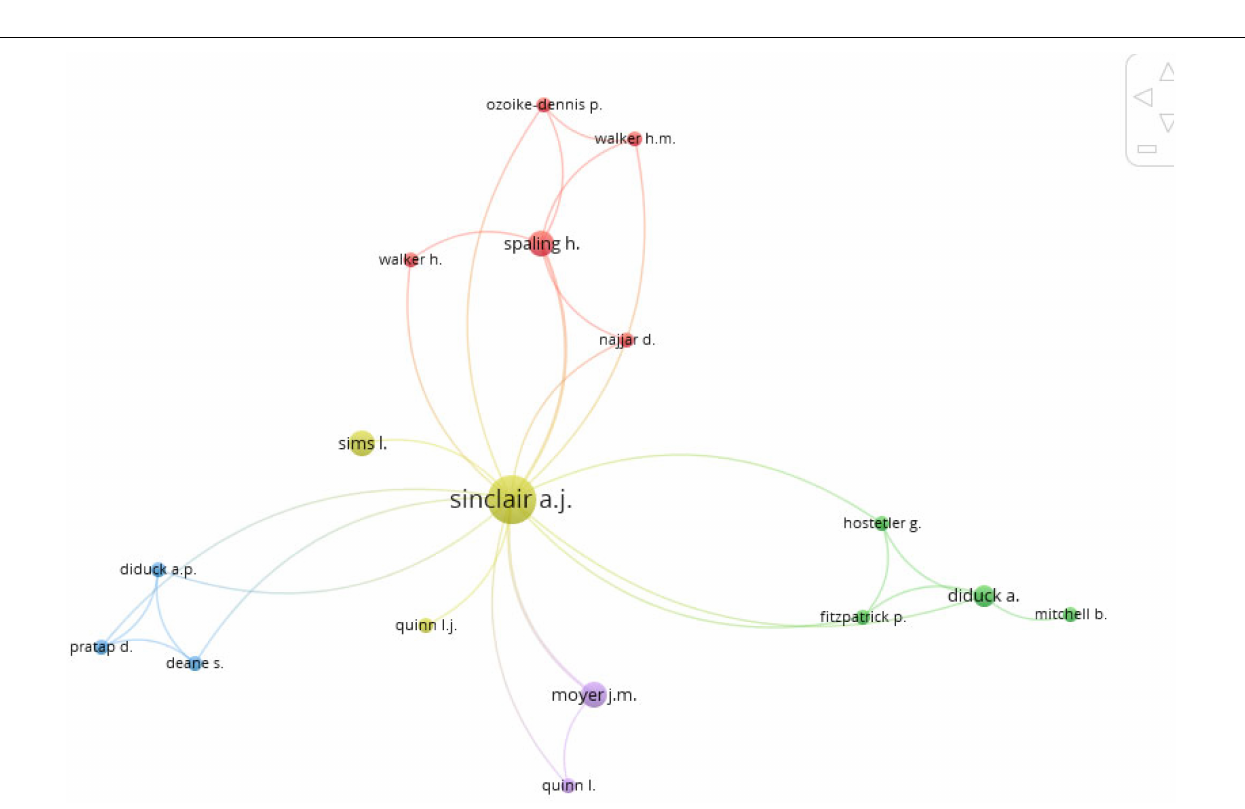
Frontiers in Education |